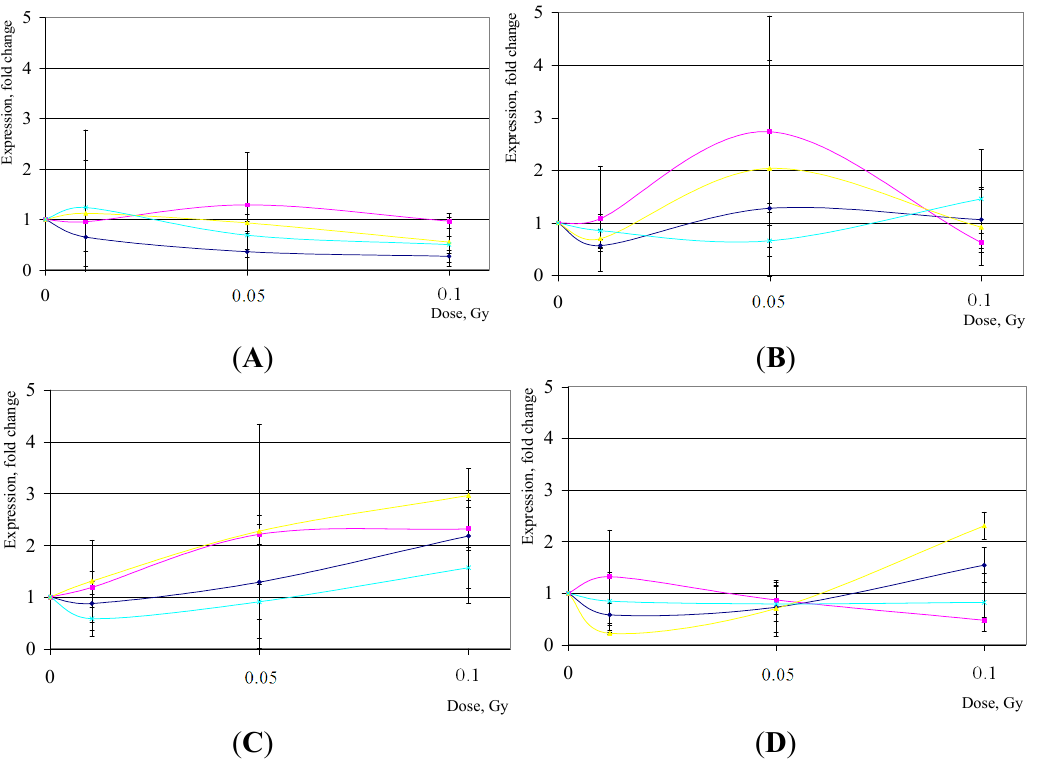
Figure 2. IER5 ( A , B ) and SESN1 ( C , D ) gene expression changes in hESCs after LD of IR exposures. Shown are mean relative quantities (±SD) for cell cultures post treatments compared to sham-IR. In violet, H1 hESC line; in pink, H7; in yellow, H9; and in blue, H14. ( A , C ), gene expression changes 2 h post-IR; ( B , D ), 16 h post-IR,